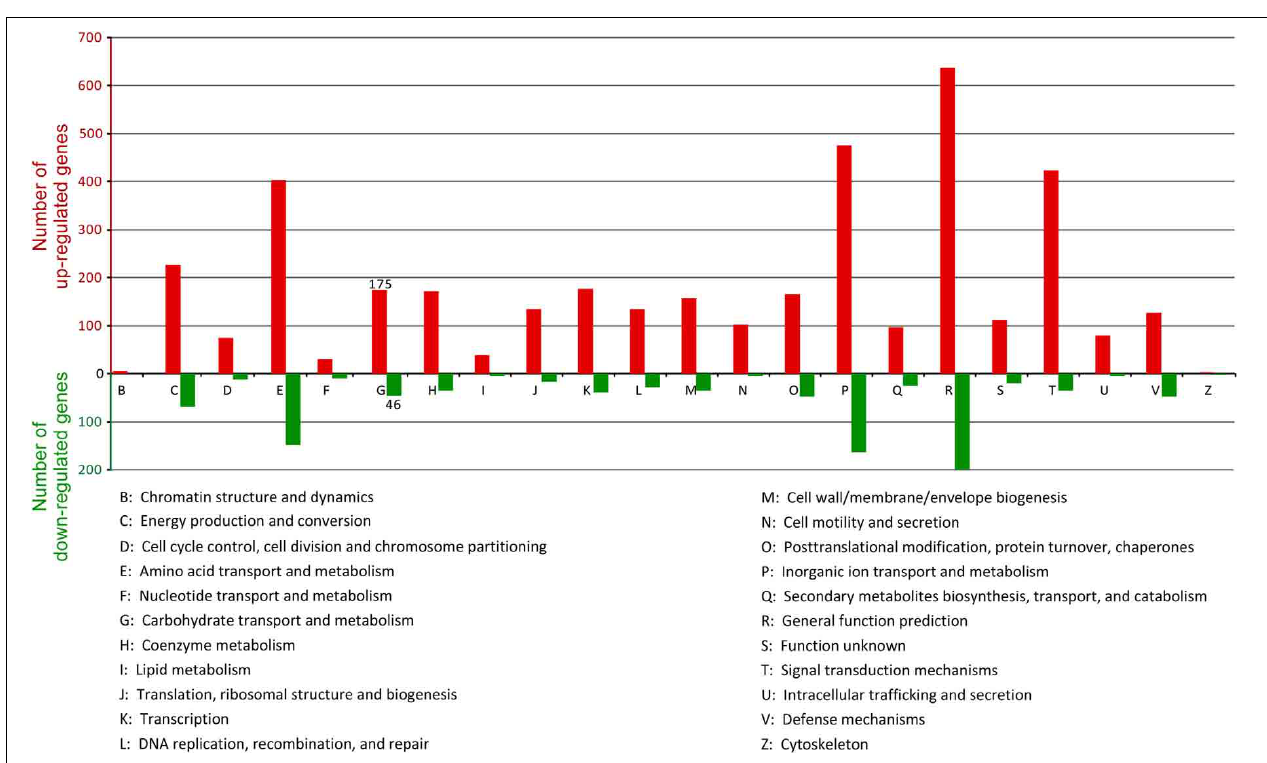
FIGURE 4 | COG functional categories of the 1211 up- and 314 down-regulated genes in PYP-grown cells compared with cellobiose-grown cells. Note that since COG annotation classes overlap, the sum of COG annotated genes is larger than the number of total up- and down-regulated genes analyzed.